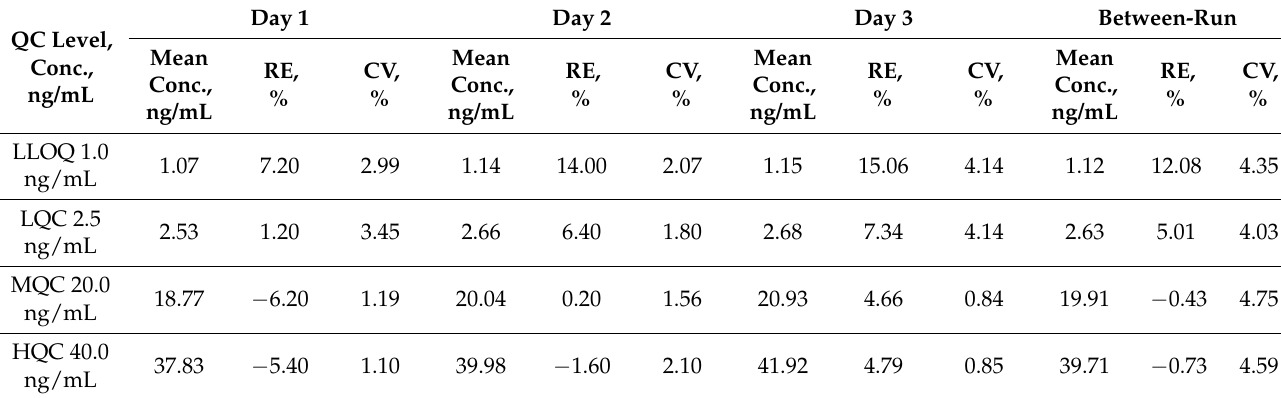
Table A7. Accuracy and precision data for DAML.